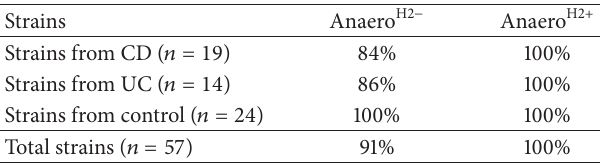
Table 1: Positive growth rates of oral C. concisus strains under Anaero H2 − and Anaero H2+ conditions. Strains Anaero H2 − Anaero H2+ Strains from CD ( 𝑛 = 19 ) 84% 100% Strains from UC ( 𝑛 = 14 ) 86% 100% Strains from control ( 𝑛 = 24 ) 100% 100% Total strains ( 𝑛 = 57 ) 91% 100% Anaero H2 − : anaerobic conditions without H 2 . Anaero H2+ : anaerobic conditions with H 2 . All strains did not grow under microaerobic conditions without H 2 (Micro H2 − a and Micro H2 − b